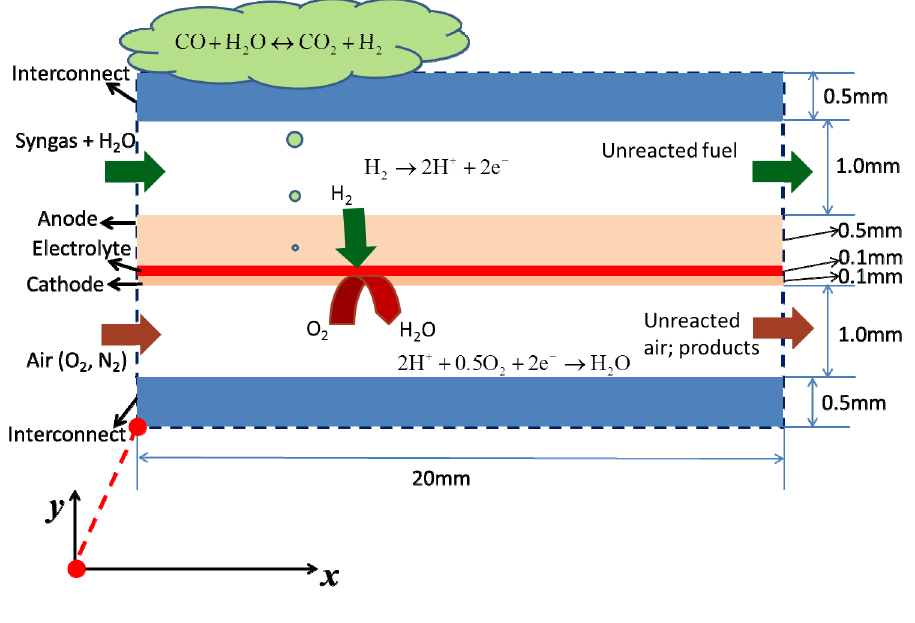
Figure 1. Working principle of syngas fueled H-SOFC and the computational